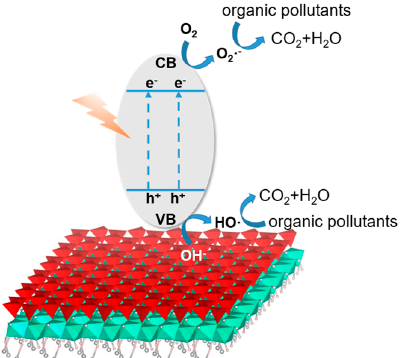
Figure 2. Schematic illustration of photocatalytic reaction mechanism.